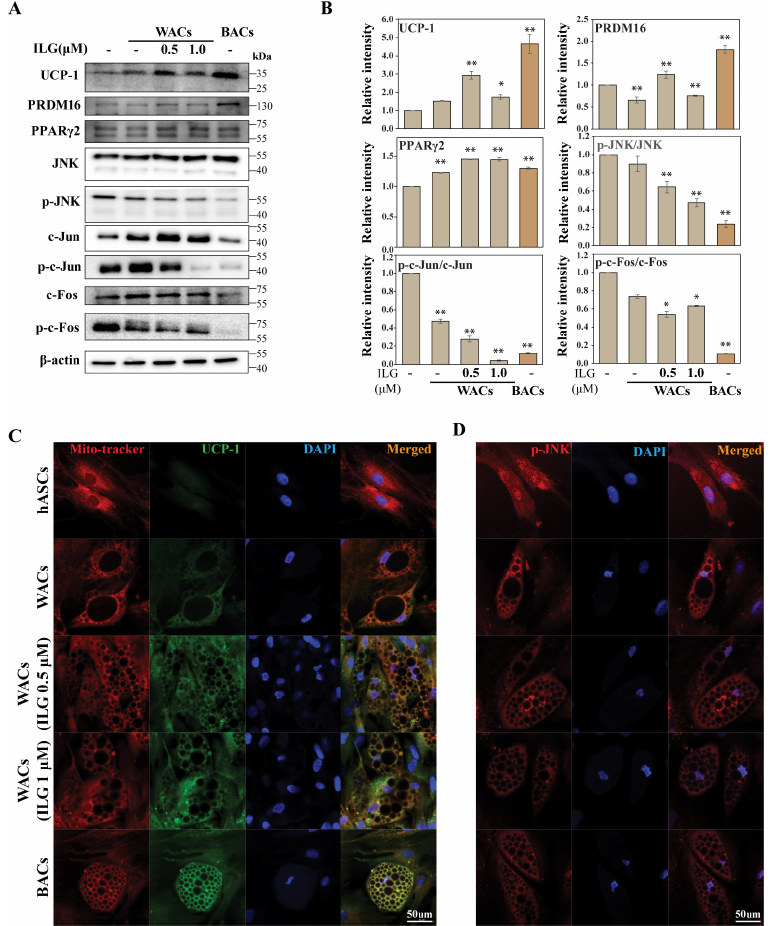
Figure 4. ILG treatment increased the BAC di ff erentiation of WACs. ( A ) Validation of di ff erentially regulated browning markers by immunoblot analysis. ( B ) The expression levels of the indicated BAC-specific proteins were quantified by Western blot analysis. Expression changes of UCP-1 and JNK by ILG treatment. Immunofluorescent staining of ( C ) UCP1 and ( D ) p-JNK. Scale bar = 50 µ m. The data were normalized to β -actin antibody and analyzed using ImageJ software; n = 3 independent experiments; * p < 0.05 and ** p <